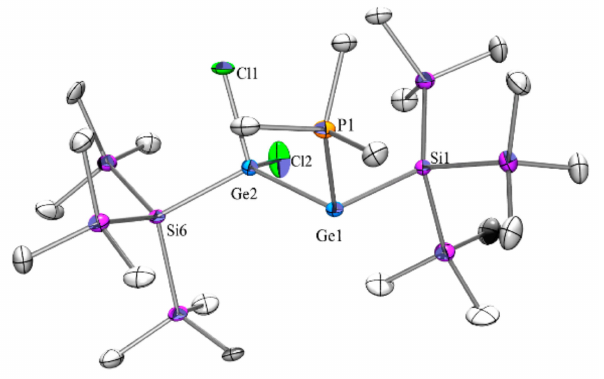
Figure 1. The molecular structure of 3 (only one of two independent molecules in the asymmetric unit is shown; the thermal ellipsoid plot is drawn at the 30% probability level). All hydrogen atoms omitted for clarity (bond length in Å, angles in deg). Ge(1)–P(1) 2.380(3), Ge(1)–Si(1) 2.489(3), Ge(1)–Ge(2) 2.5210(18), Ge(2)–Cl(2) 2.208(4), Ge(2)–Cl(1) 2.253(3), Ge(2)–Si(6) 2.428(3), Si(1)–Si(2) 2.361(4), Si(2)–C(1) 1.864(14), P(1)–C(11) 1.807(13), P(1)–Ge(1)-Si(1) 99.69(11), P(1)–Ge(1)–Ge(2) 93.80(9), Si(1)–Ge(1)-Ge(2) 105.64(9), Cl(2)–Ge(2)-Cl(1) 99.49(17), Cl(2–Ge(2)-Si(6) 102.67(14), Cl(1)–Ge(2)–Si(6) 101.21(12), Cl(2)–Ge(2)–Ge(1) 108.28(12), Cl(1)–Ge(2)-Ge(1) 116.19(10), Si(6)–Ge(2)–Ge(1)